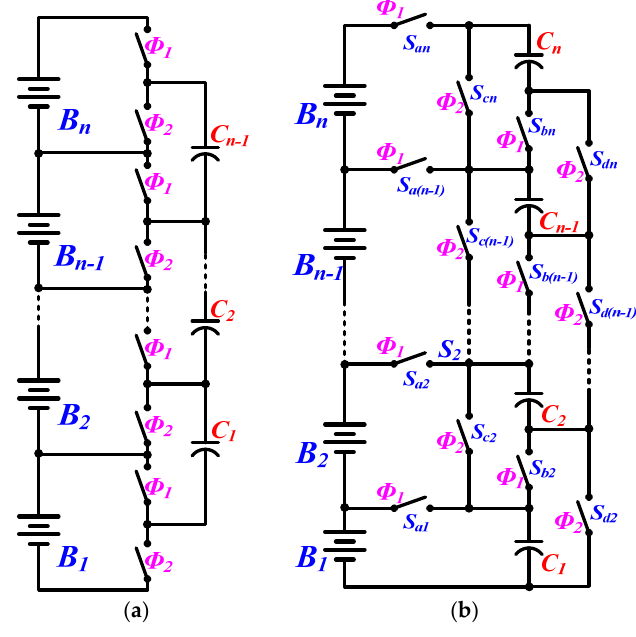
Figure 1. Switched-capacitor (SC) voltage equalizer of battery strings: ( a ) conventional version; and ( b ) proposed version.